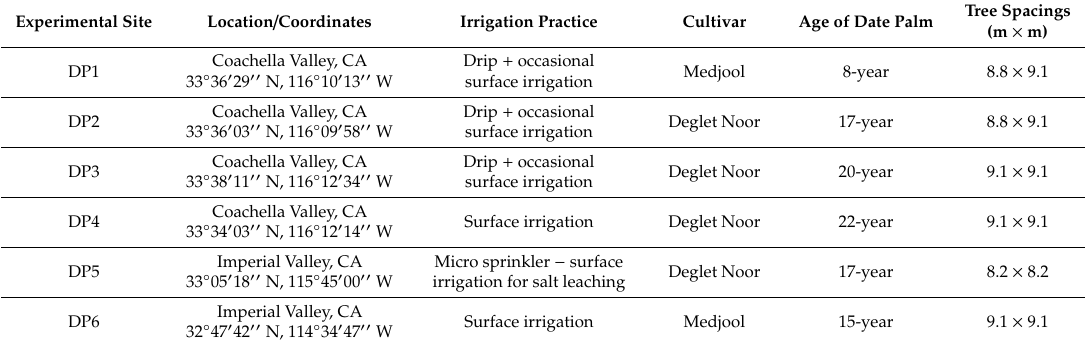
Table 1. General information for date palm sites 1–6 (DP1, DP2, DP3, DP4, DP5, and DP6). Experimental Site